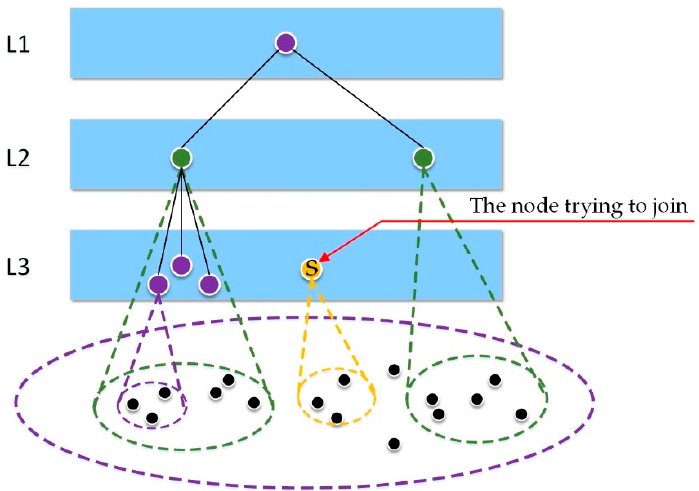
Figure 2. LNMRS implementation based on the tree structure.